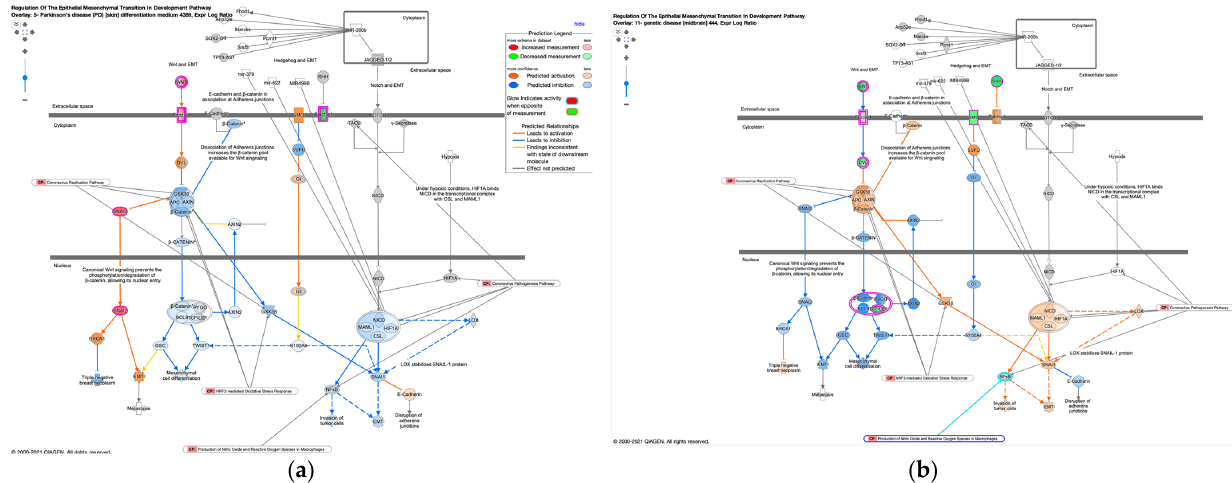
Figure 5. Regulation of EMT in development pathway in diseases. ( a ) Parkinson’s disease (PD) (skin) differentiation medium 4389, p value = 1.89 × 10 − 2 , z-score = 3; Gene identifiers marked with an asterisk (*) indicate that multiple identifiers in the dataset file map to a single gene in the Global Molecular Network. ( b ) genetic disease (midbrain) 444, p value = 4.75 × 10 − 2 , z-score = −